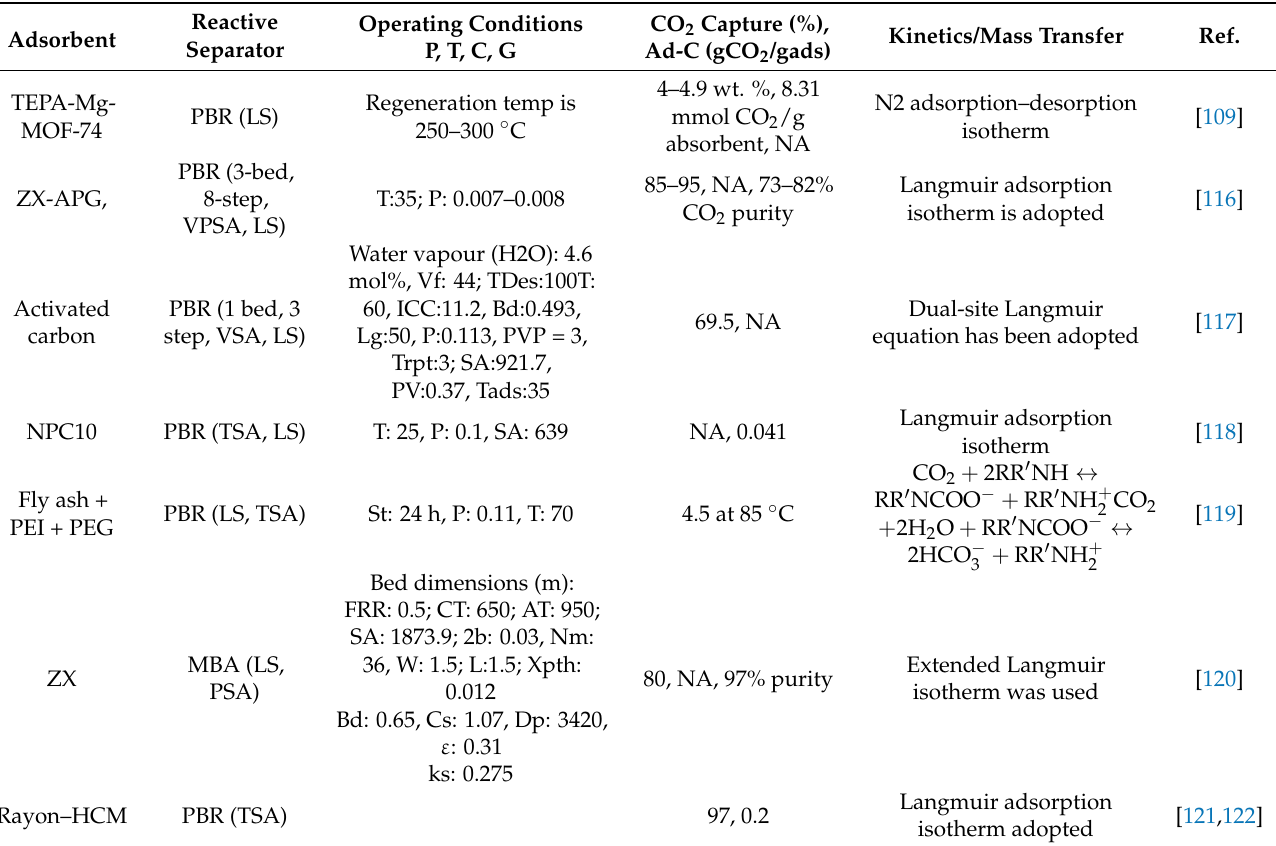
Table 4. Summary of adsorption-based carbon